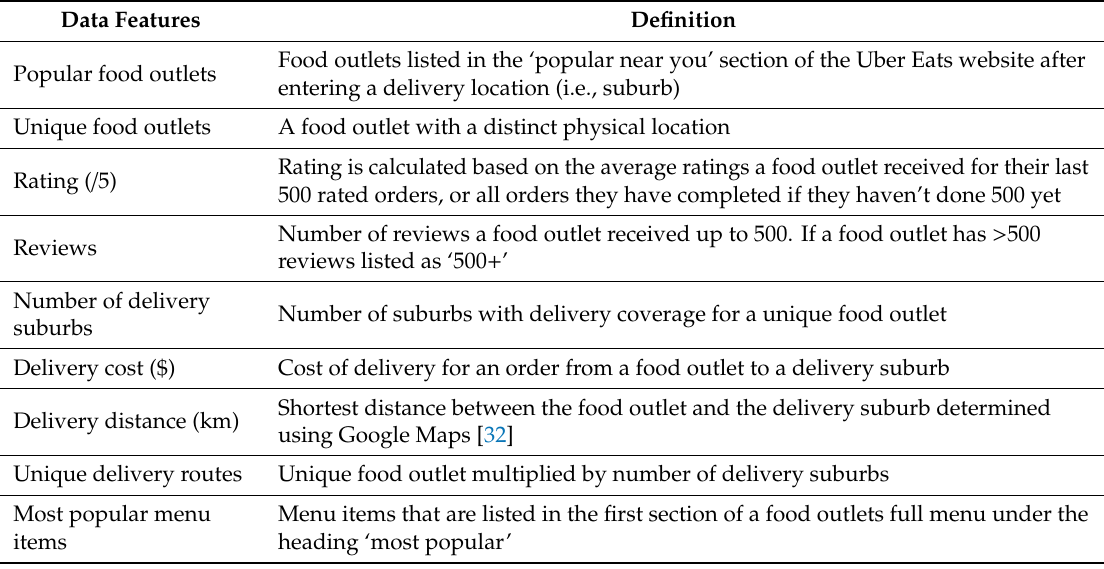
Table 1. Summary and definition of data extracted from food outlets and